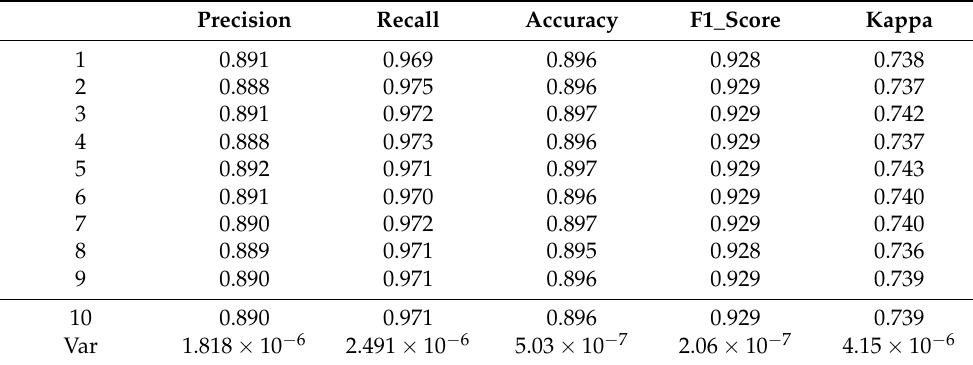
Figure 5. Ablation experiments. Table 6. Metrics result of ten FGDEM